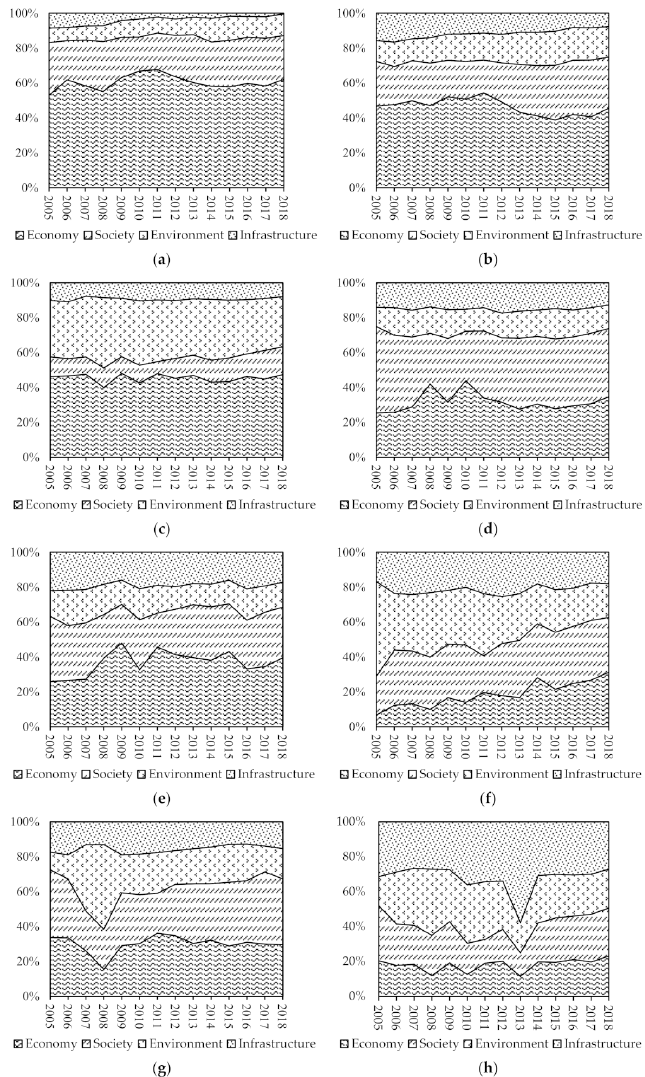
Figure 3. Structural sources of differences in urban resilience development among the eight urban agglomerations. ( a ) Beijing Tianjin Hebei (BTH). ( b ) Yangtze River Delta (YRD). ( c ) Pearl River Delta (PRD). ( d ) Middle Reaches of the Yangtze River (MYR). ( e ) Chengdu Chongqing (CC). ( f ) Guanzhong (GP). ( g ) Harbin Changchun (HC). ( h ) Central Plains